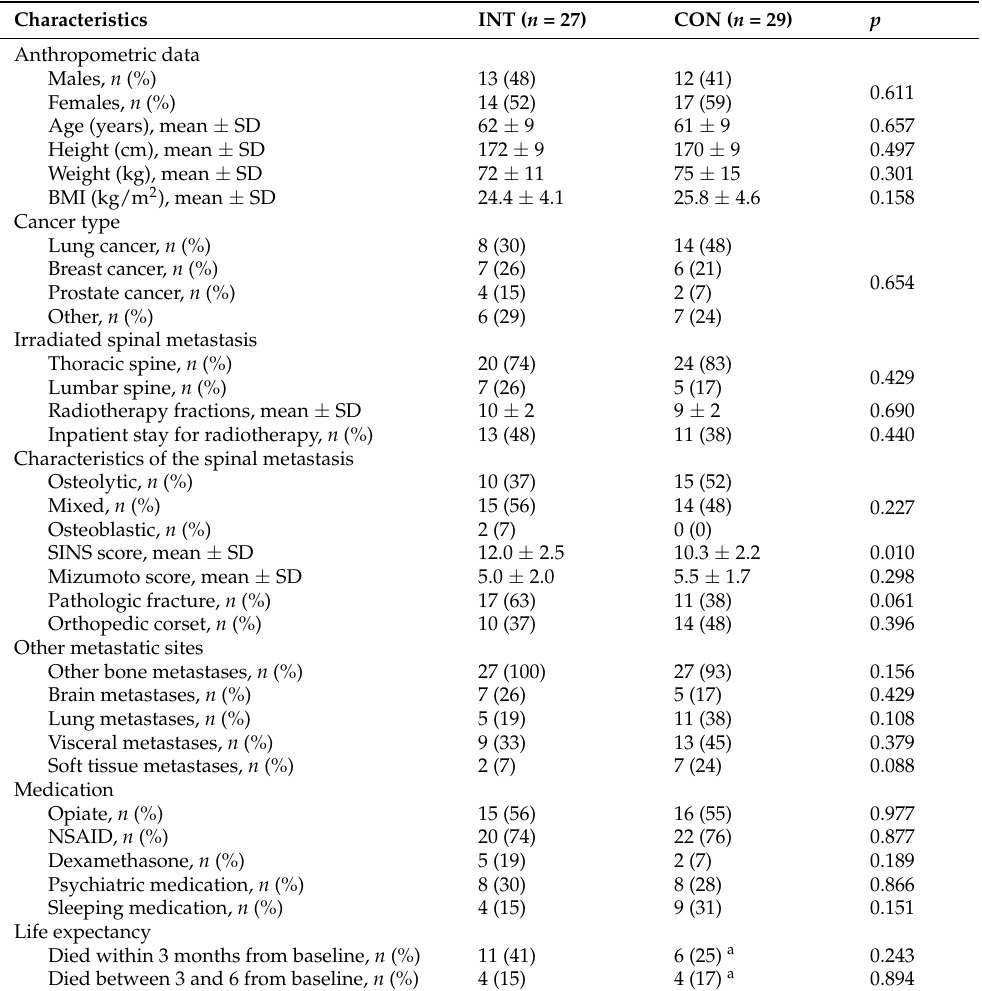
Table 1. Patient baseline